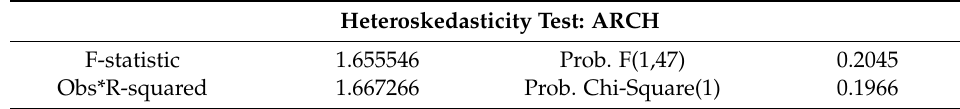
Table 10. ARCH test of